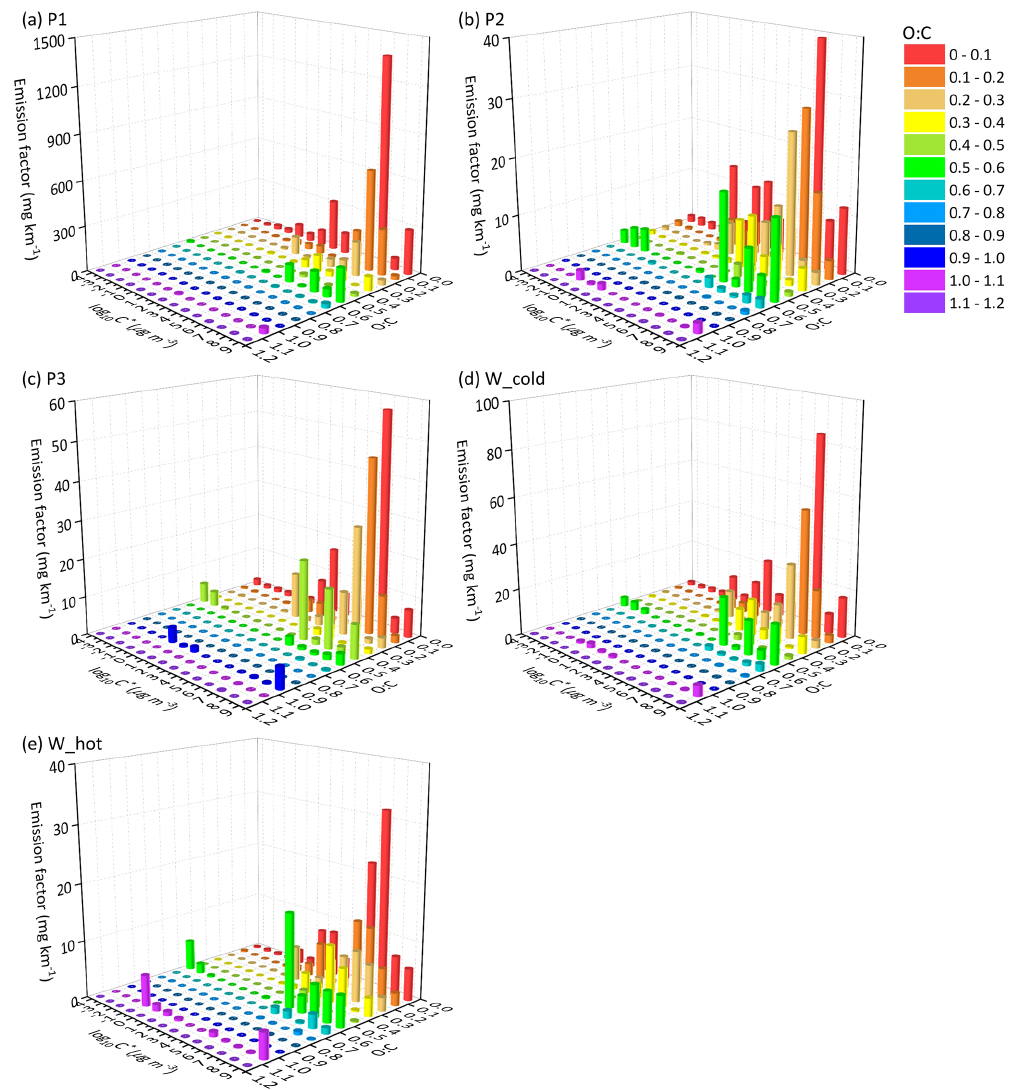
Figure 4. The EF distribution of the speciated I/SVOCs of (DPF + DOC) vehicles on a 2D-VBS space of (a) low-speed stage (P1), (b) middle-speed stage (P2), (c) high-speed stage (P3), (d) whole (W_cold), and whole (W_hot) driving cycles. Different colors indicate different O:C ratios segmented into 12 bins: 0–0.1, 0.1–0.2, 0.2–0.3, 0.3–0.4, 0.4–0.5, 0.5–0.6, 0.6–0.7, 0.7–0.8, 0.8–0.9, 0.9–1.0, and